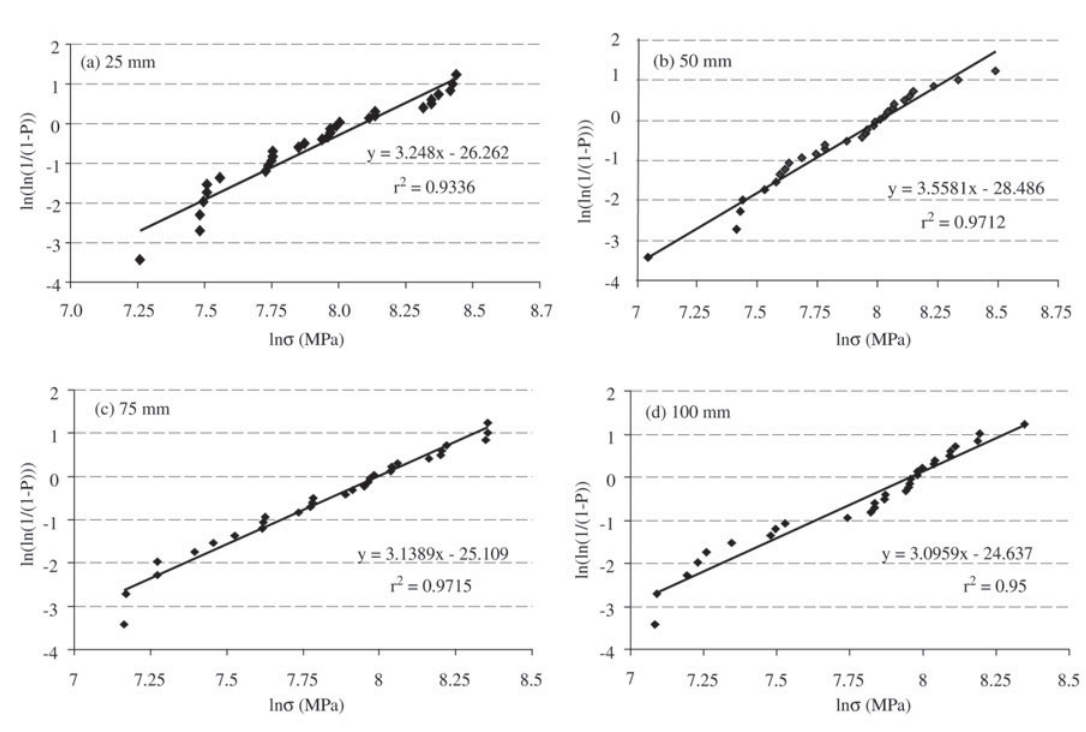
Figure 12. Weibull plots for tensile strength of carbon fibres of length 25 mm, 50 mm, 75 mm and 100